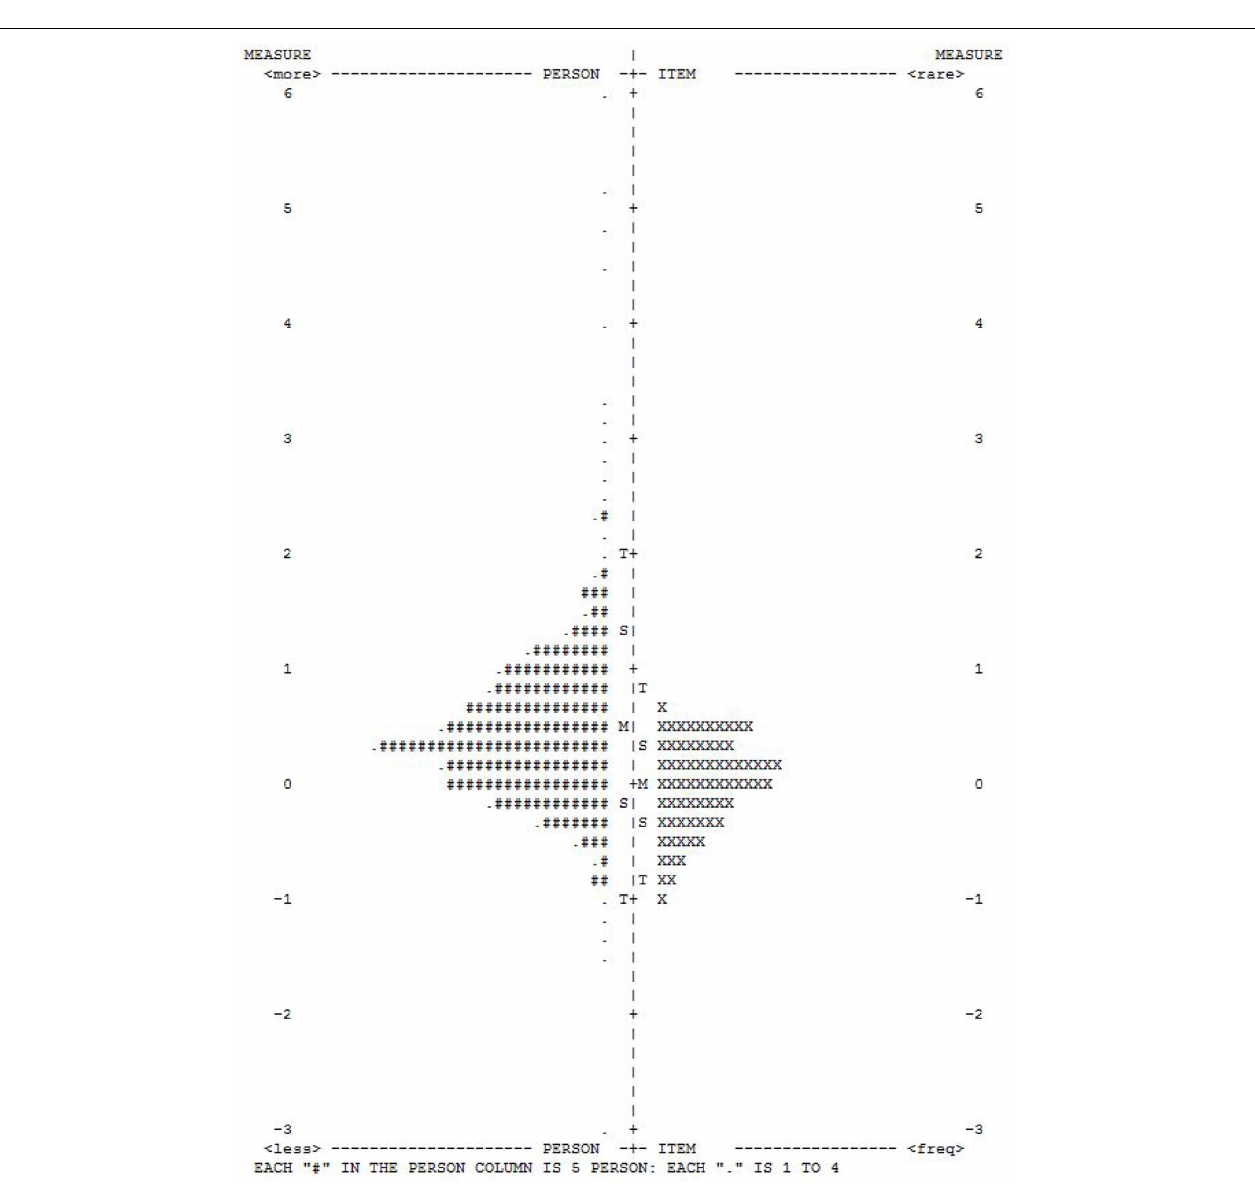
FIGURE 1 | Variable map for the STEM Student Attitude Survey calibration which illustrates the match between person measures and item measures. EACH (cid:48)(cid:48) # (cid:48)(cid:48) IS 10: EACH (cid:48)(cid:48) . (cid:48)(cid:48) IS 1 TO 9.